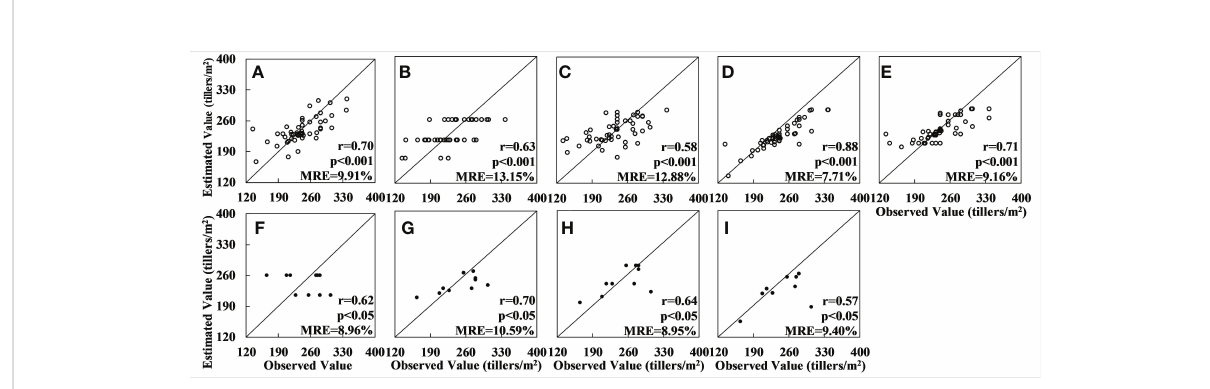
FIGURE 4 Accuracy of tiller density estimates based on Sentinel-2 data: (A – E) are the regression results obtained by applying, respectively, the OLS, RF, SVM, GBRT, and XGBoost models to the training set; (F – I) are the results obtained by applying, respectively, the RF, SVM, GBRT, and XGBoost models to the validation set. (The results for the OLS model could not be fi tted and no results for the accuracy were